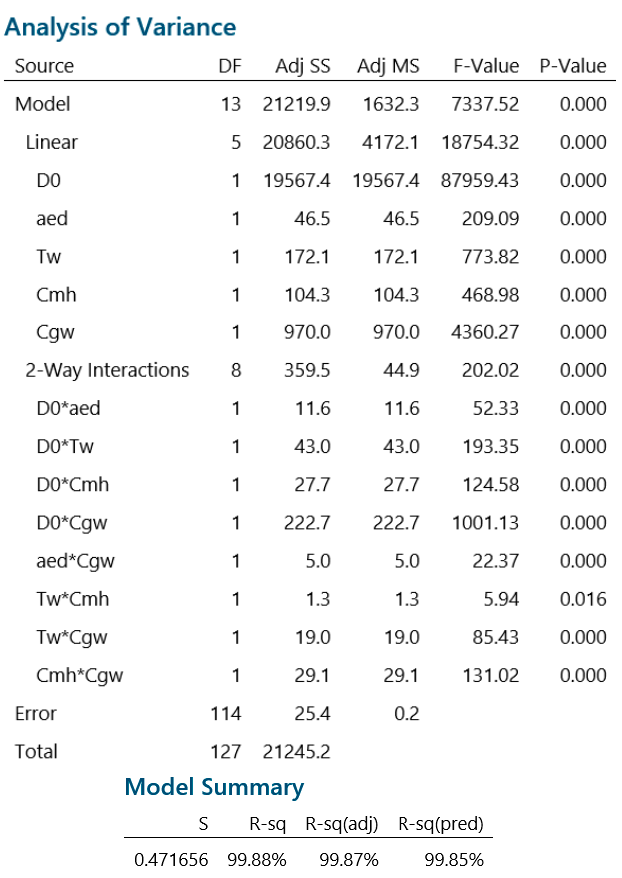
Figure 6. Pareto chart for D op.